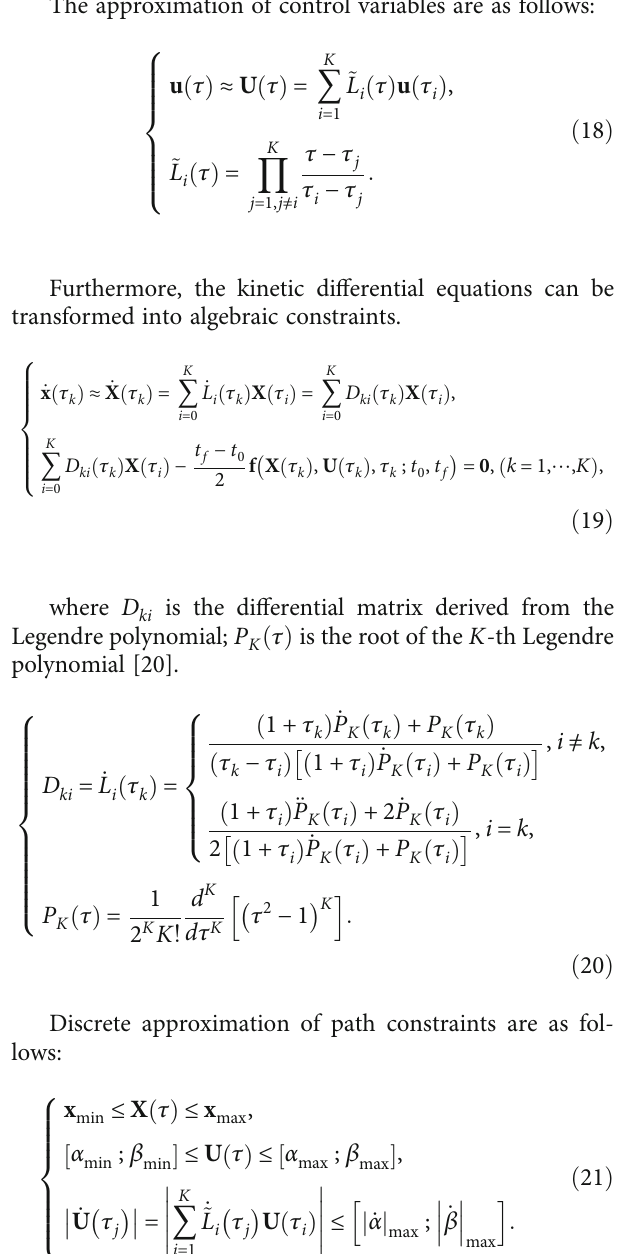
g and τ , ⋯ , τ 1 0 K